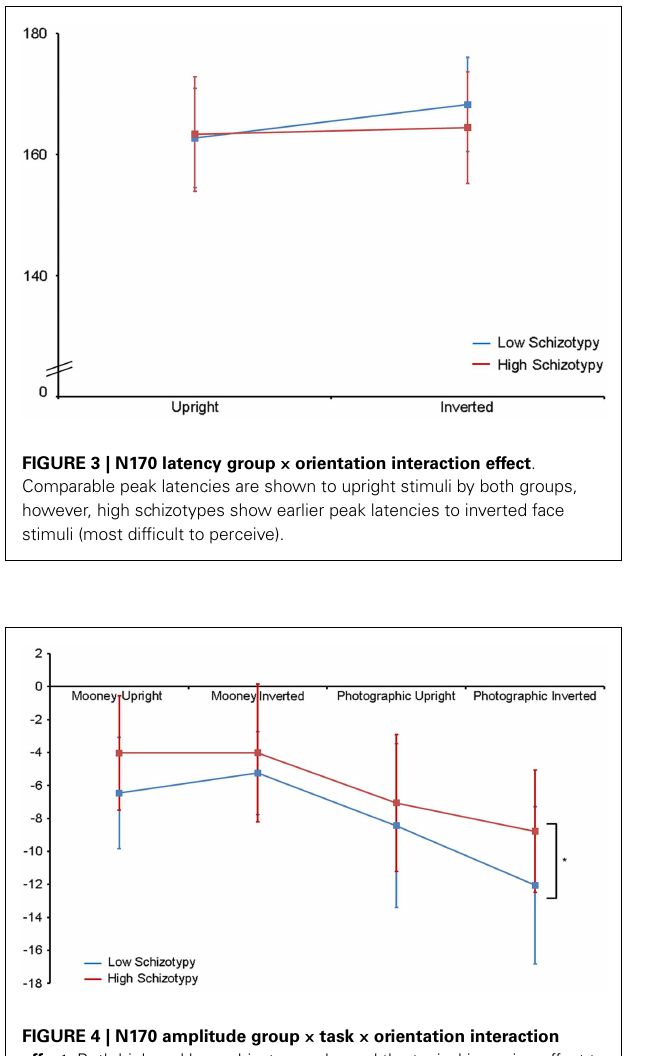
FIGURE 4 | N170 amplitude group × task × orientation interaction effect . Both high and low schizotypes showed the typical inversion effect to photographic stimuli: larger N170 amplitude to inverted versus upright photographic faces (although this difference is smaller for the high schizotypes). However, only low schizotypes showed an inversion effect to Mooney faces (reversed: smaller amplitudes to inverted compared with upright Mooney faces). High schizotypes instead showed comparable amplitude to Mooney faces irrespective of orientation. Note the